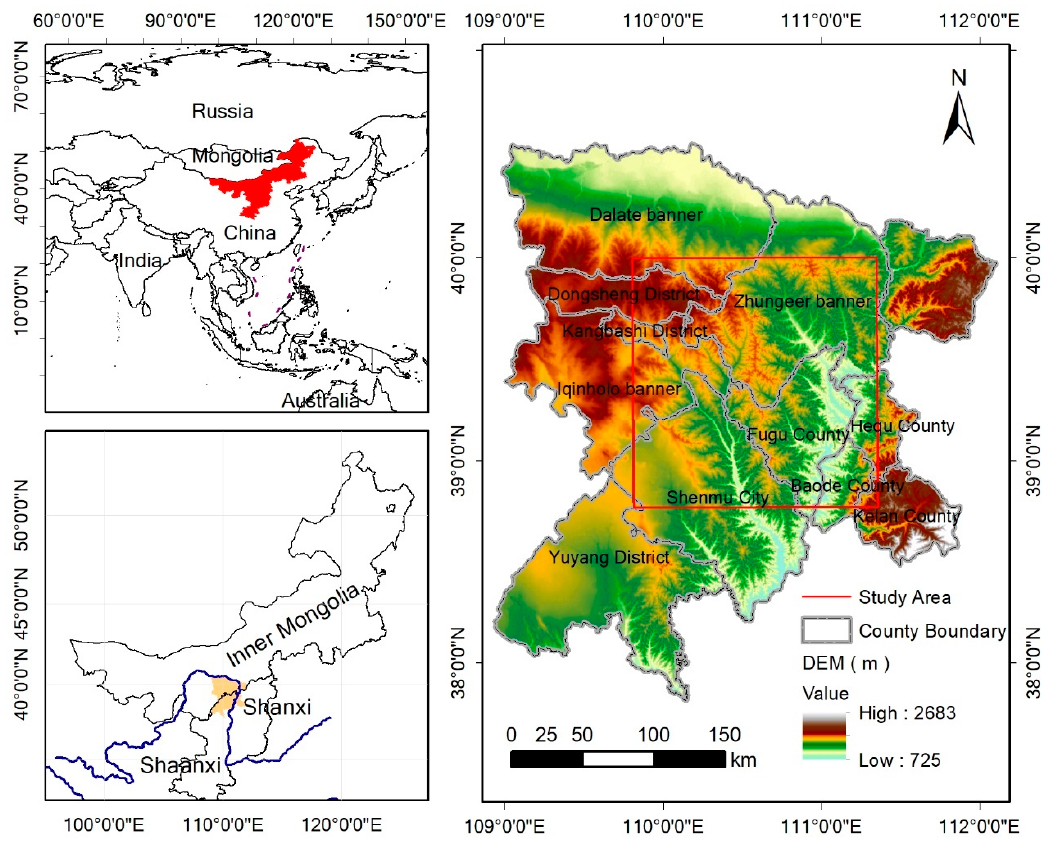
Figure 2. The location of the mining areas .